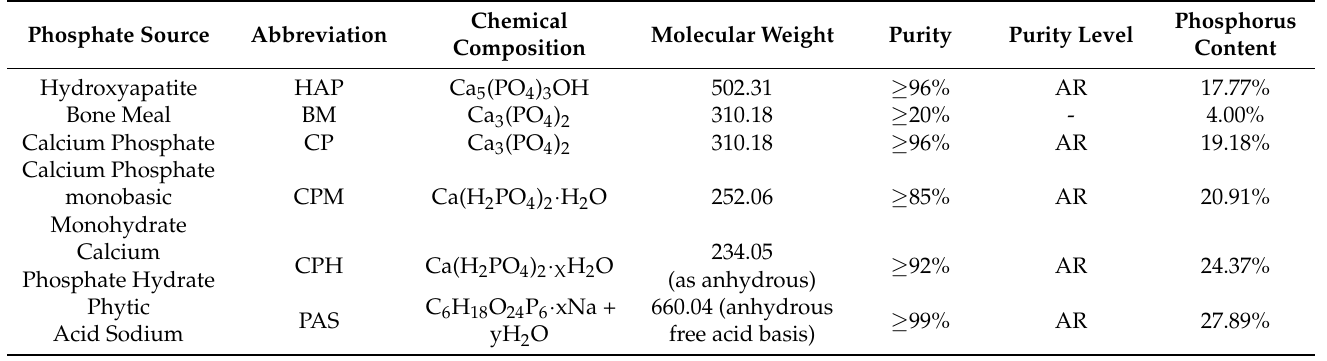
Table 1. Chemical characteristics of experimental phosphate